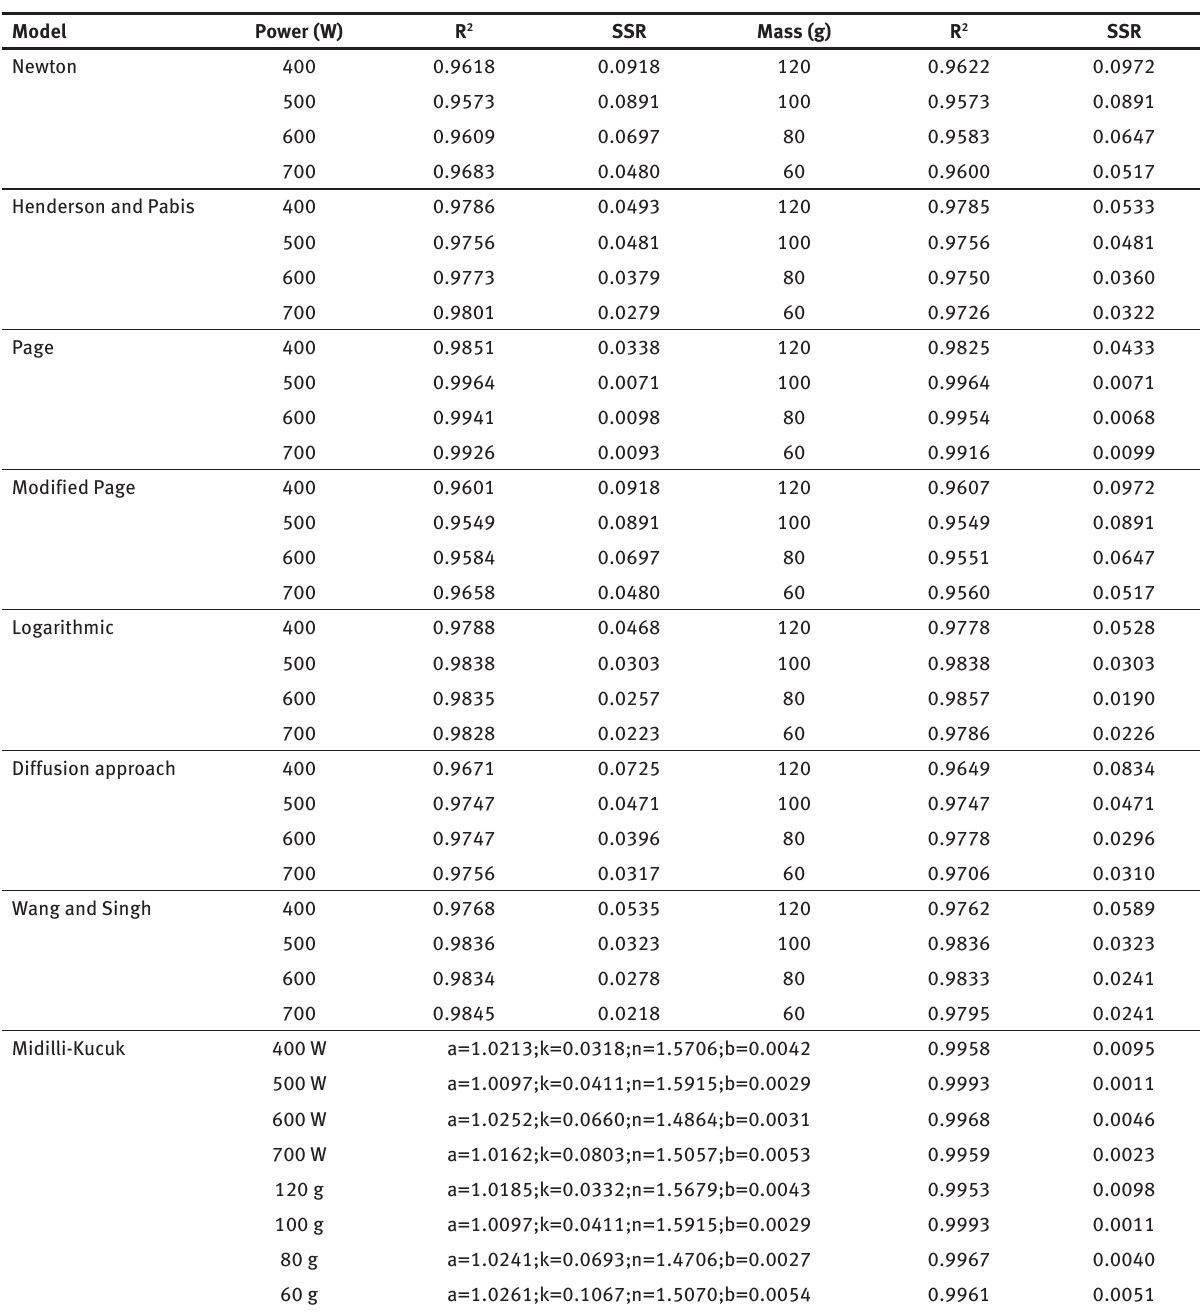
Table 3: Statistical analysis of each model at various microwave powers.